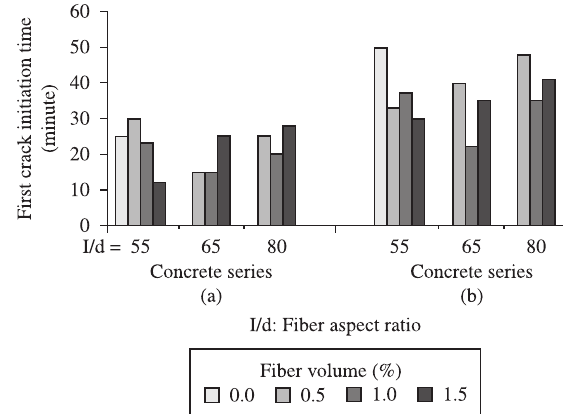
Figure 4. Effect of fiber volume on total plastic shrinkage crack length (mm), for series A and series B